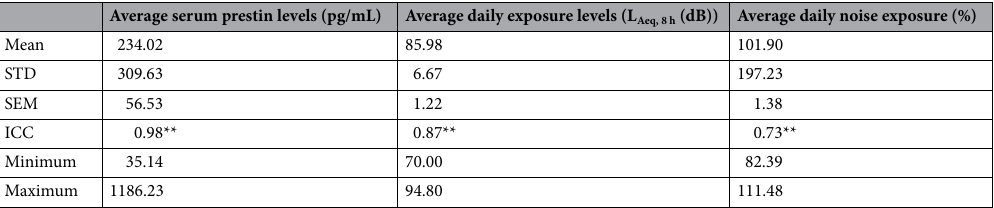
Table 1. Descriptive statistics. STD standard deviation, SEM standard error of the mean, ICC intraclass correlations across 5 sessions (prestin) or 3 rounds (noise). **p < 0.001.